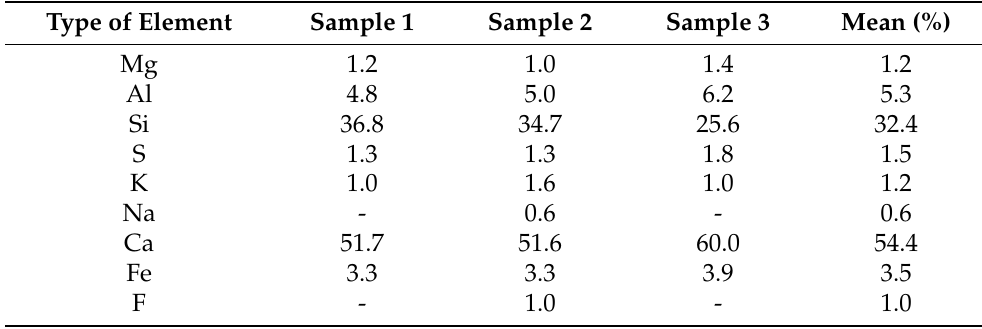
Table 8. Element compositions of samples taken from the cover layer of the concrete structure as determined by EDS.